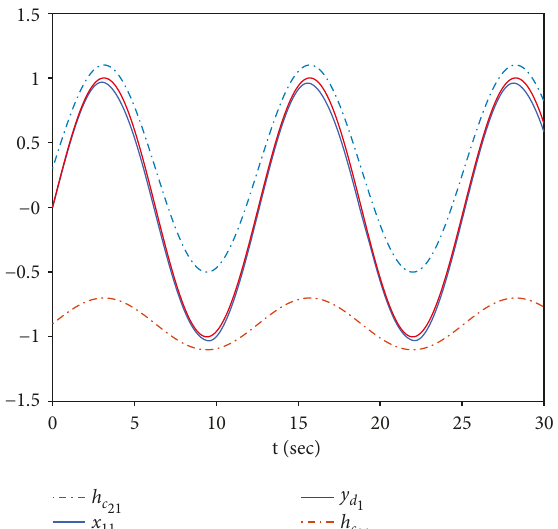
of Link 1 and ideal 11